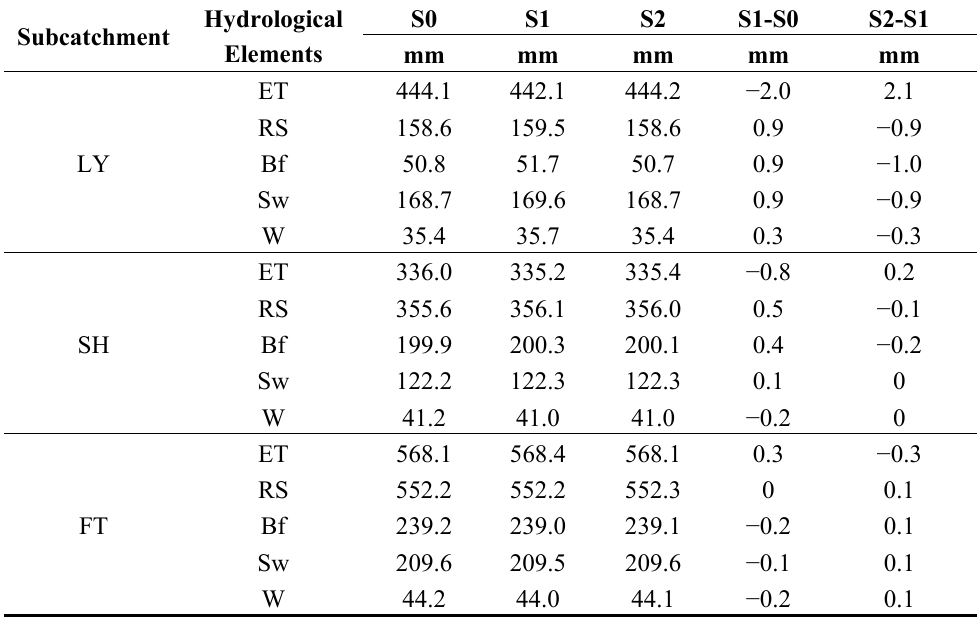
Table 9. Hydrological regimes for the 1985, 1995 and 2000 land use